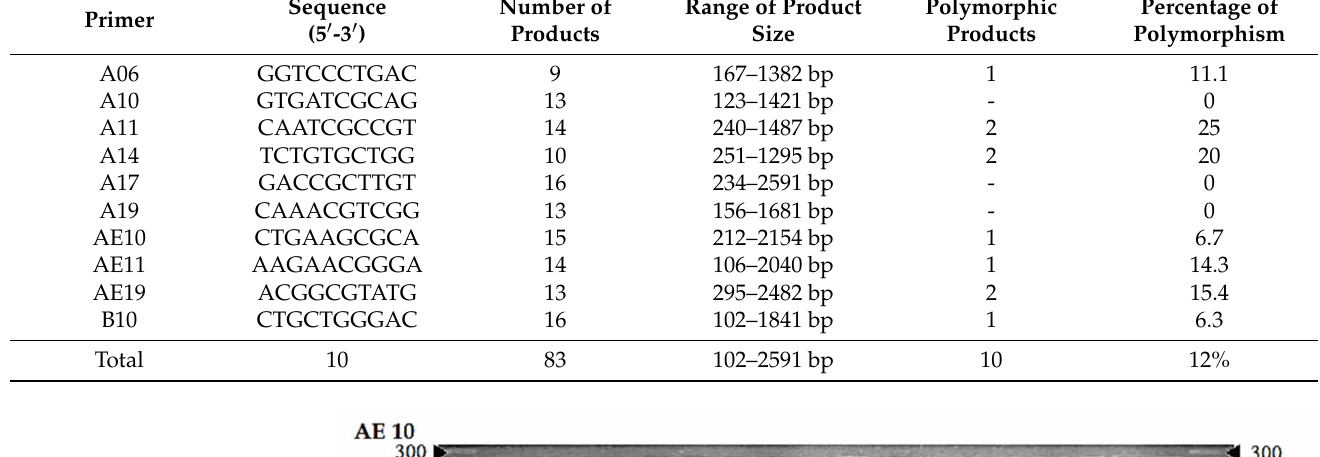
Table 2. Qualities of the RAPD primers applied in the molecular analyses.